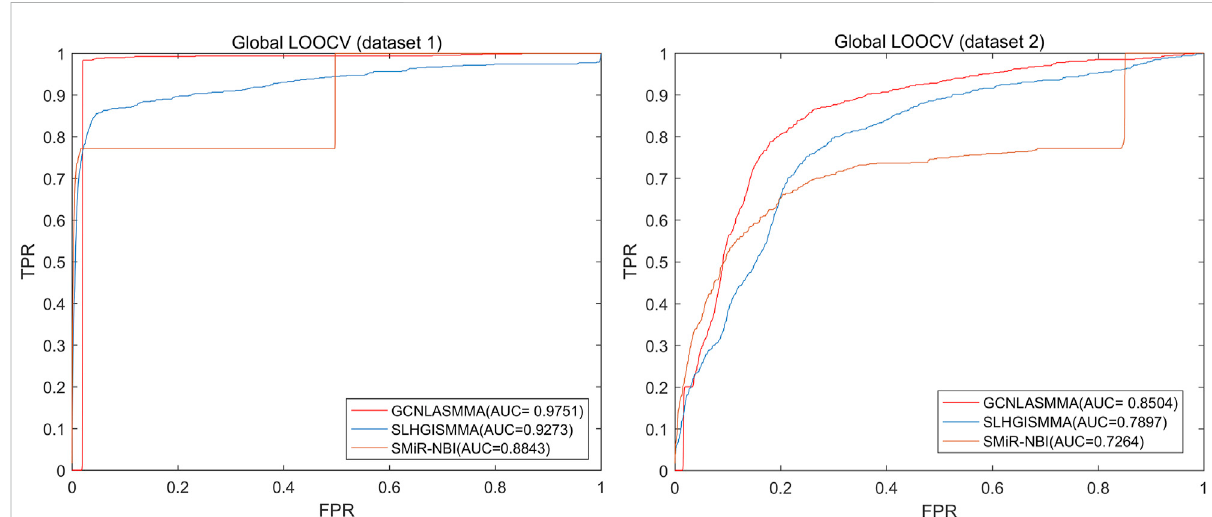
FIGURE 2 Thelefthalfofthe fi gureshows thecomparisonofGCNLASMMA withtwocomparisonalgorithmsunderglobal LOOCVbasedondataset1.Asa result, GCNLASMMA, SLHGISMMA and SMiR-NBI achieve AUCs of 0.9751, 0.9273 and 0.8843, respectively. The right half of the fi gure shows the comparison of GCNLASMMA with two comparison algorithms under global LOOCV based on dataset2. As a result, GCNLASMMA, SLHGISMMA and SMiR-NBI achieve AUCs of 0.8504, 0.7897 and 0.7264,